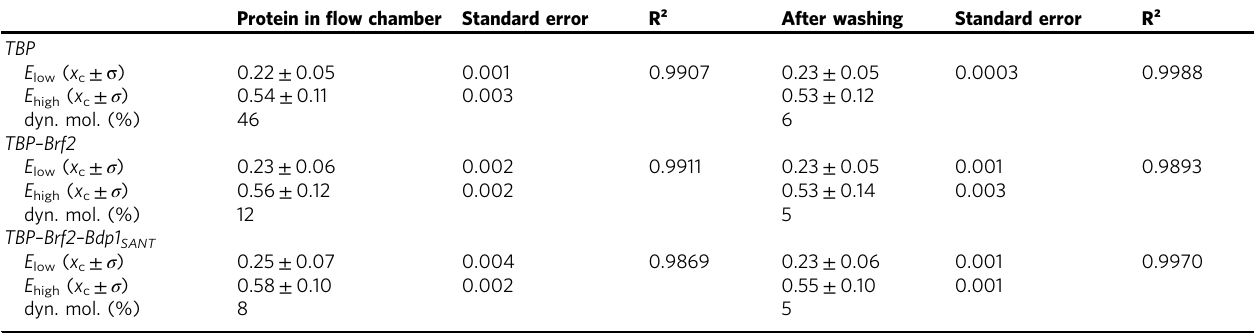
Table 2 FRET ef fi ciencies (E) and percentage of dynamic molecules for the single-molecule FRET promoter-bending essay Protein in fl ow chamber Standard